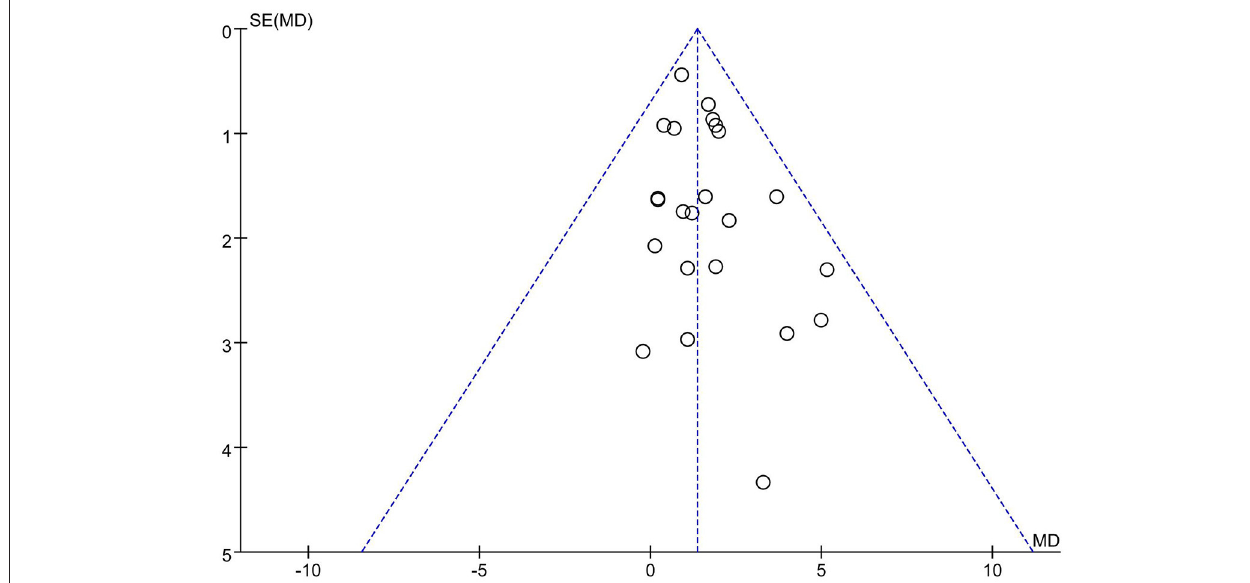
FIGURE 7 | Funnel plot of publication bias.